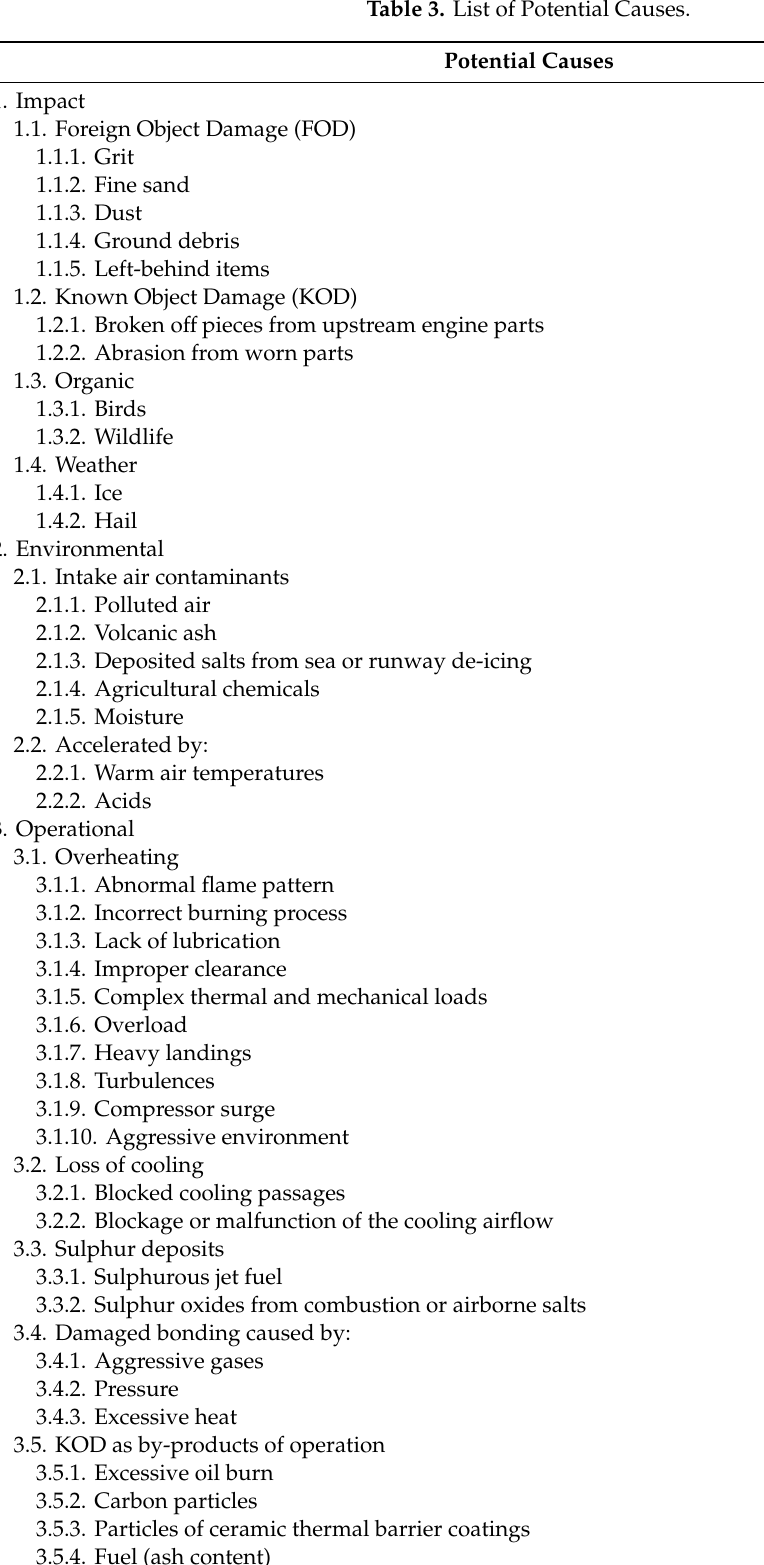
Table 3. List of Potential